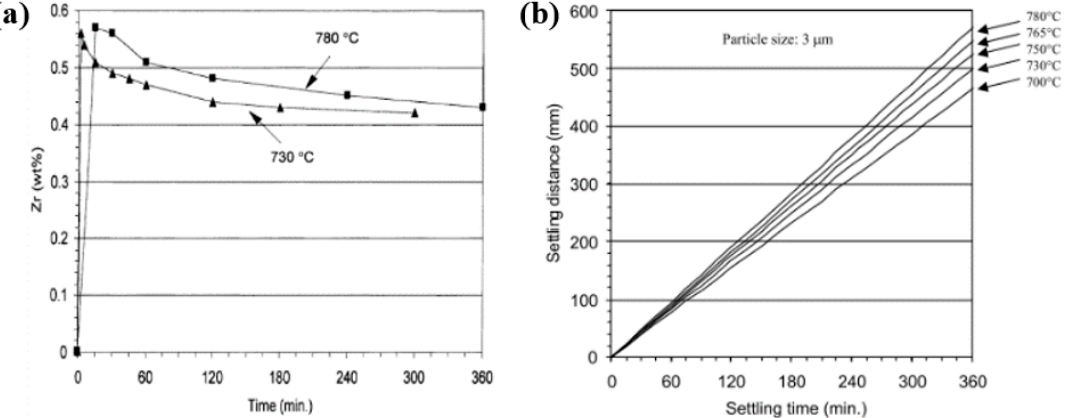
Figure 2. ( a ) Experimental results for settling; ( b ) predicted settling results of 3 μ m Zr particles in pure Mg melt as a function of time and temperature [30]. Reprinted with permission from ref. [30]. Copyright 2001 Elsevier.